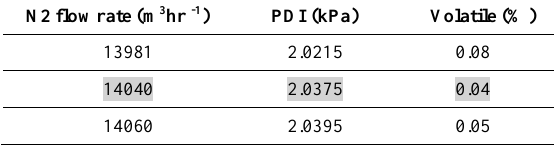
Table 3. Industrial results of double-cyclone versus nitrogen flow rate in PE100 with wet feed rate of 38000 kg hr -1 .